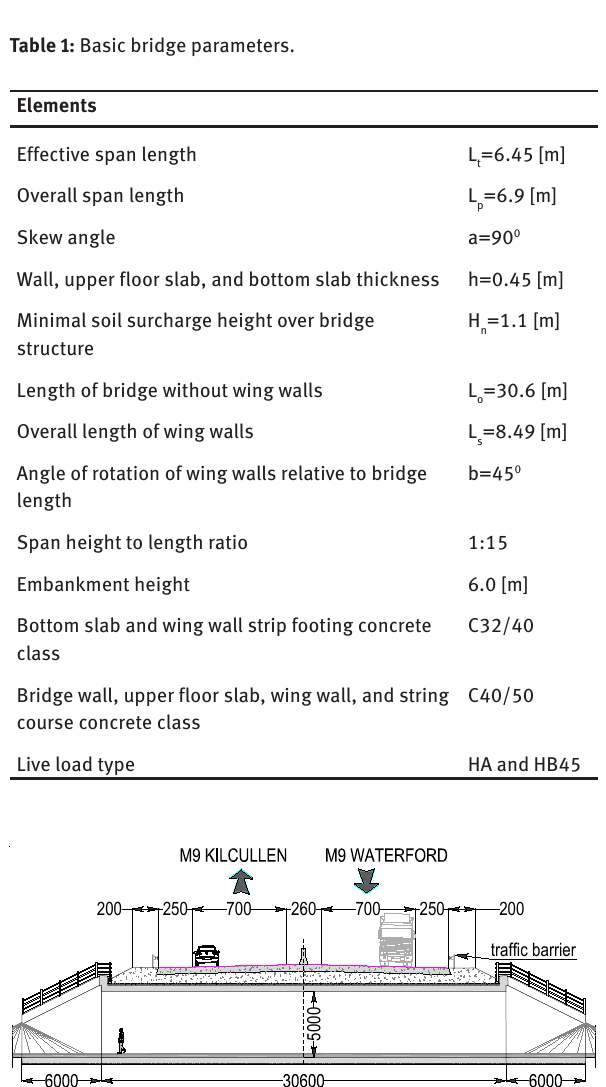
Figure 1: Longitudinal section of the bridge.